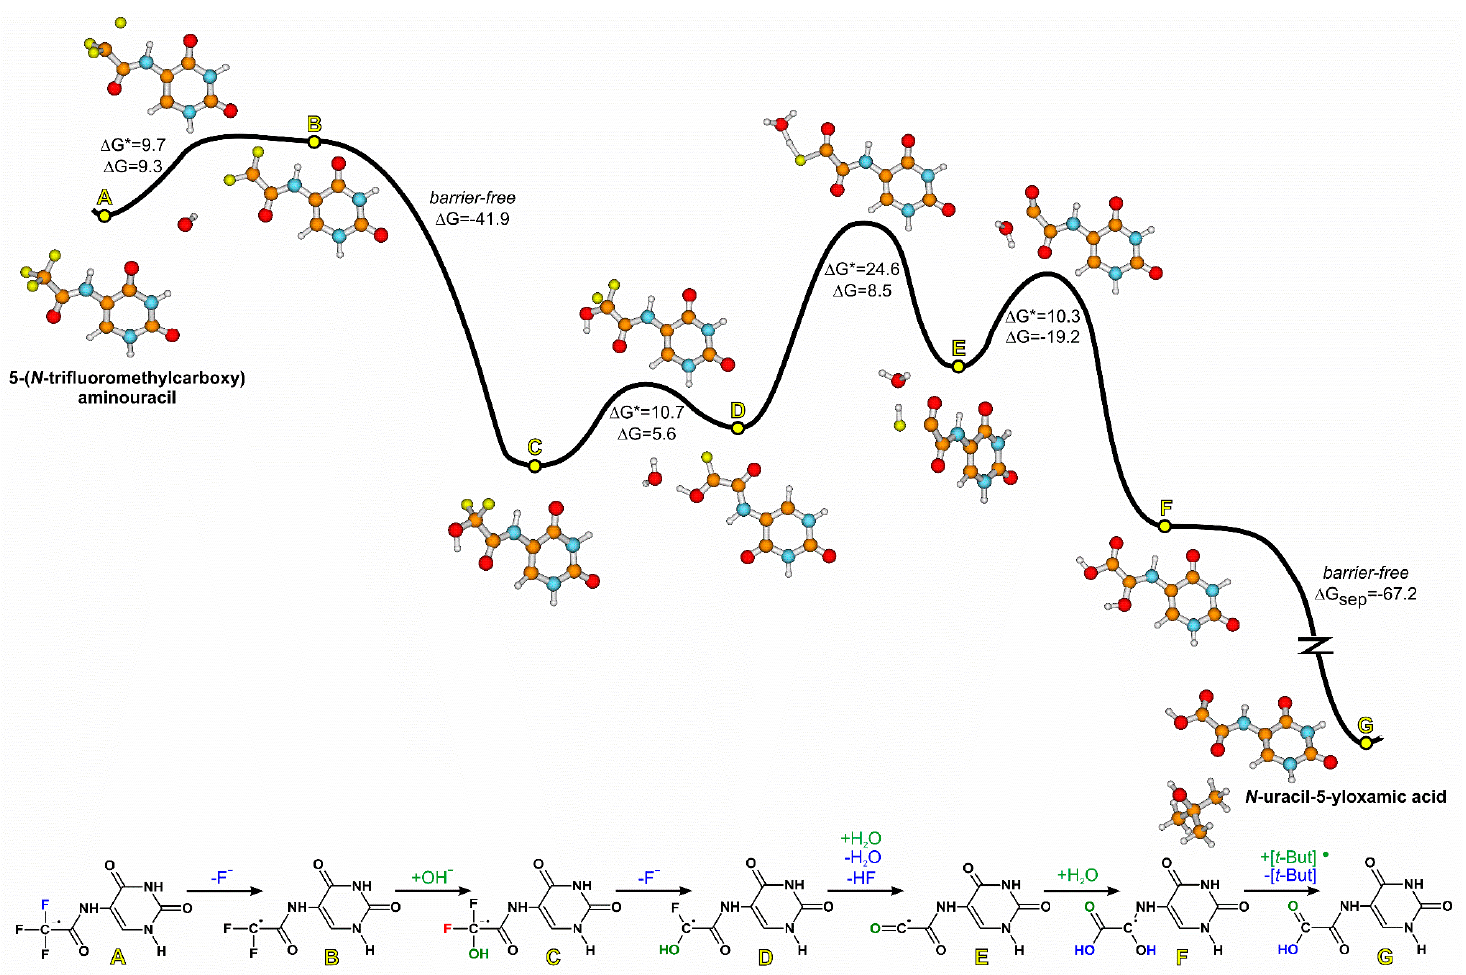
Figure 6. Gibbs free energy profile for the degradation of an anion radical of 5-( N -trifluoromethylcarboxy) aminouracil. Thermodynamic ( Δ G) and kinetic ( Δ G*) barriers in kcal mol − 1 .